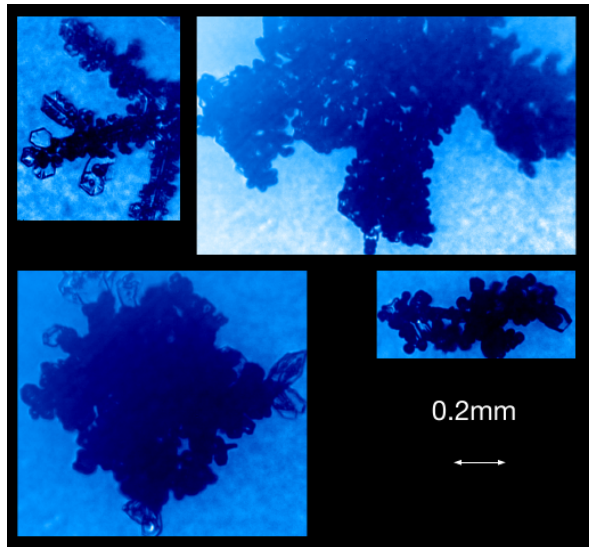
Figure 11. Examples of CPI images where rimed crystals were observed. The images were taken on 13 December 2015 between 16:14 and